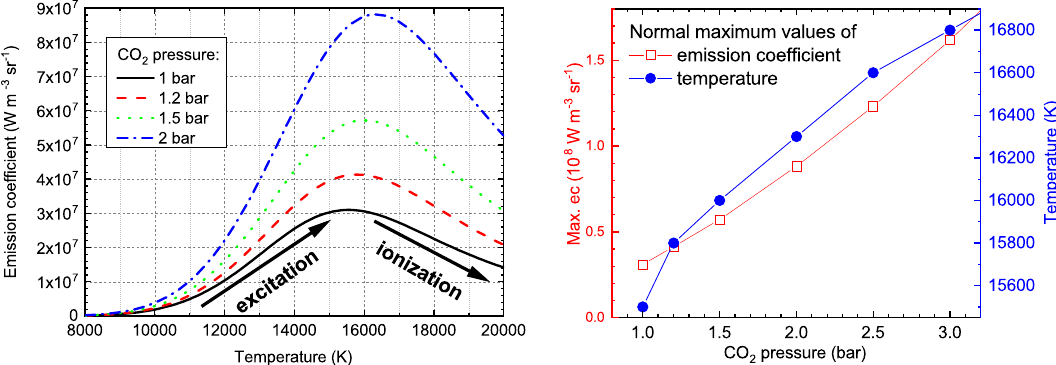
Figure 8. Left : Calculated emission coefficient of the O I 777 nm triplet at different partial pressures of CO 2 depending on temperature. Note that the normal maximum is strongly dependent on the pressure but its position is rather stable around 16,000K. Right : Pressure dependence of emission coefficient and temperature at normal